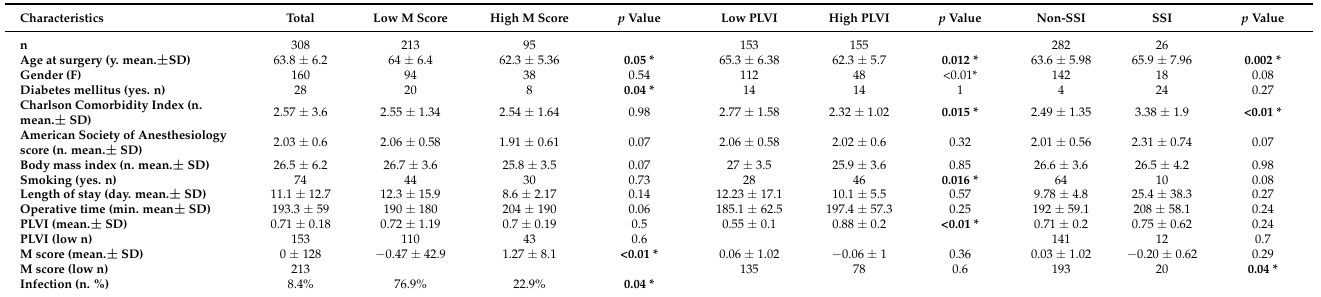
Table 1. Baseline characteristic differences for high vs. low PLVI groups, for high vs. low M-score groups, and for non-SSI vs. SSI